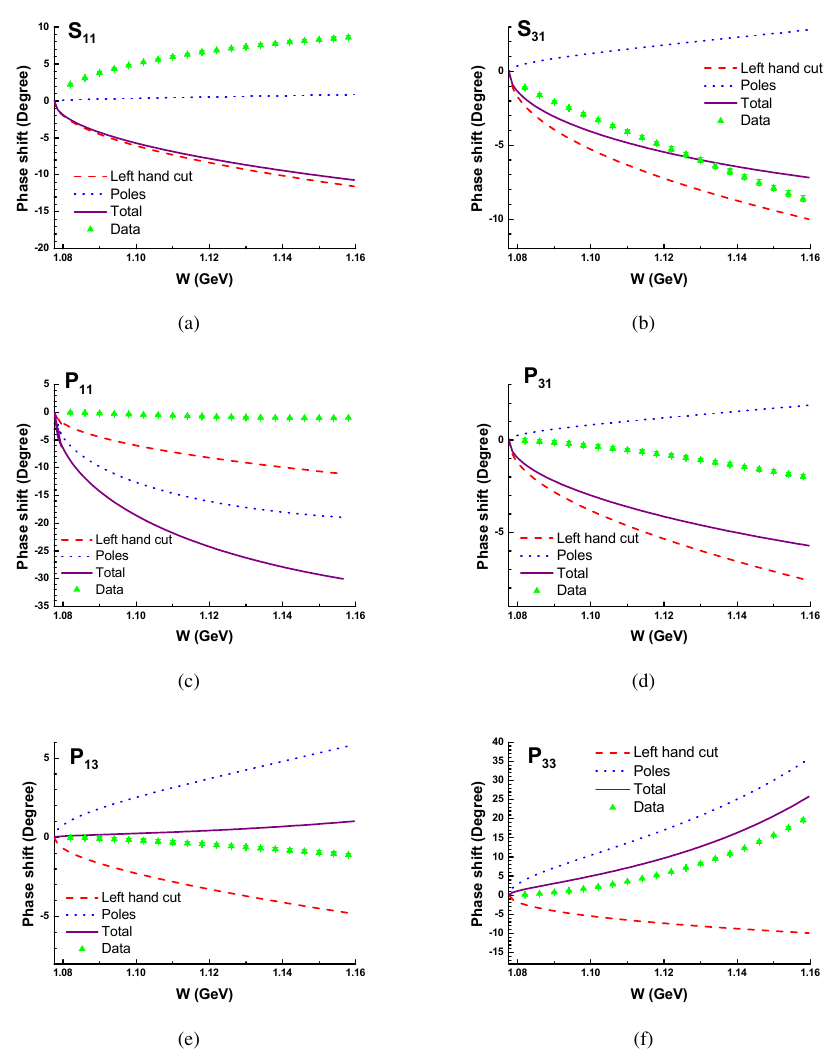
a near-threshold virtual state, though good fit quality requires a larger s c value. For example, when s c = − 9 . 00 GeV 2 the virtual state locates at 980 MeV. Such a virtual state lying above the nucleon pole is actually needed physically, since it can be regarded as the kinematic companionate pole of the nucleon. On the first Riemann sheet, S ( s ) can be expanded in